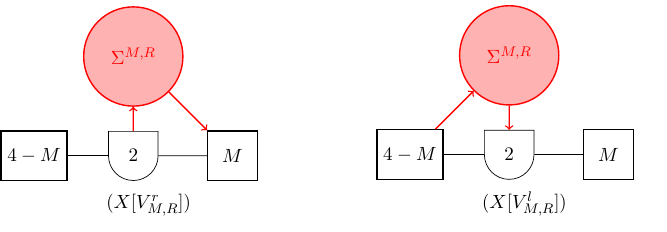
Figure 28 . A family of vortex defects V M,R in the theory X and the associated 3d-1d coupled